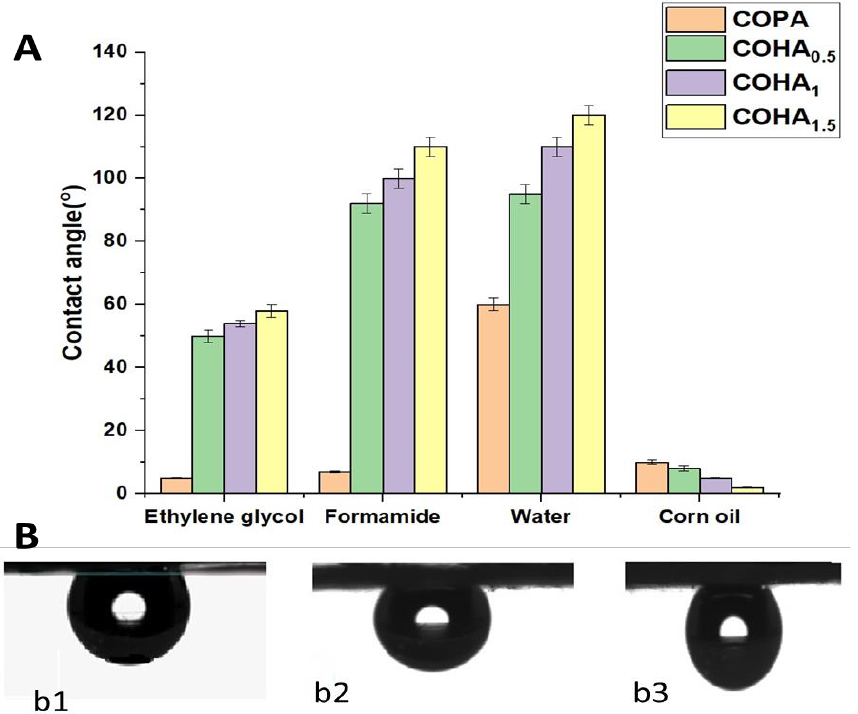
Figure 7. ( A ) Contact angle measurements for different solvents on neat COPA and COHA nano- composite membranes. ( B ) Underwater oil contact angle ( b1 -COHA 0.5 , b2 -COHA 1 and b3 -COHA 1.5 ).